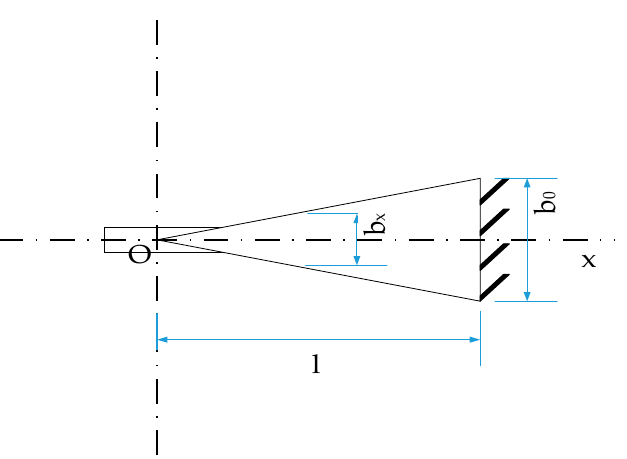
Figure 3. S tructure of the triangle cantilever beam. Figure 3. Structure of the triangle cantilever